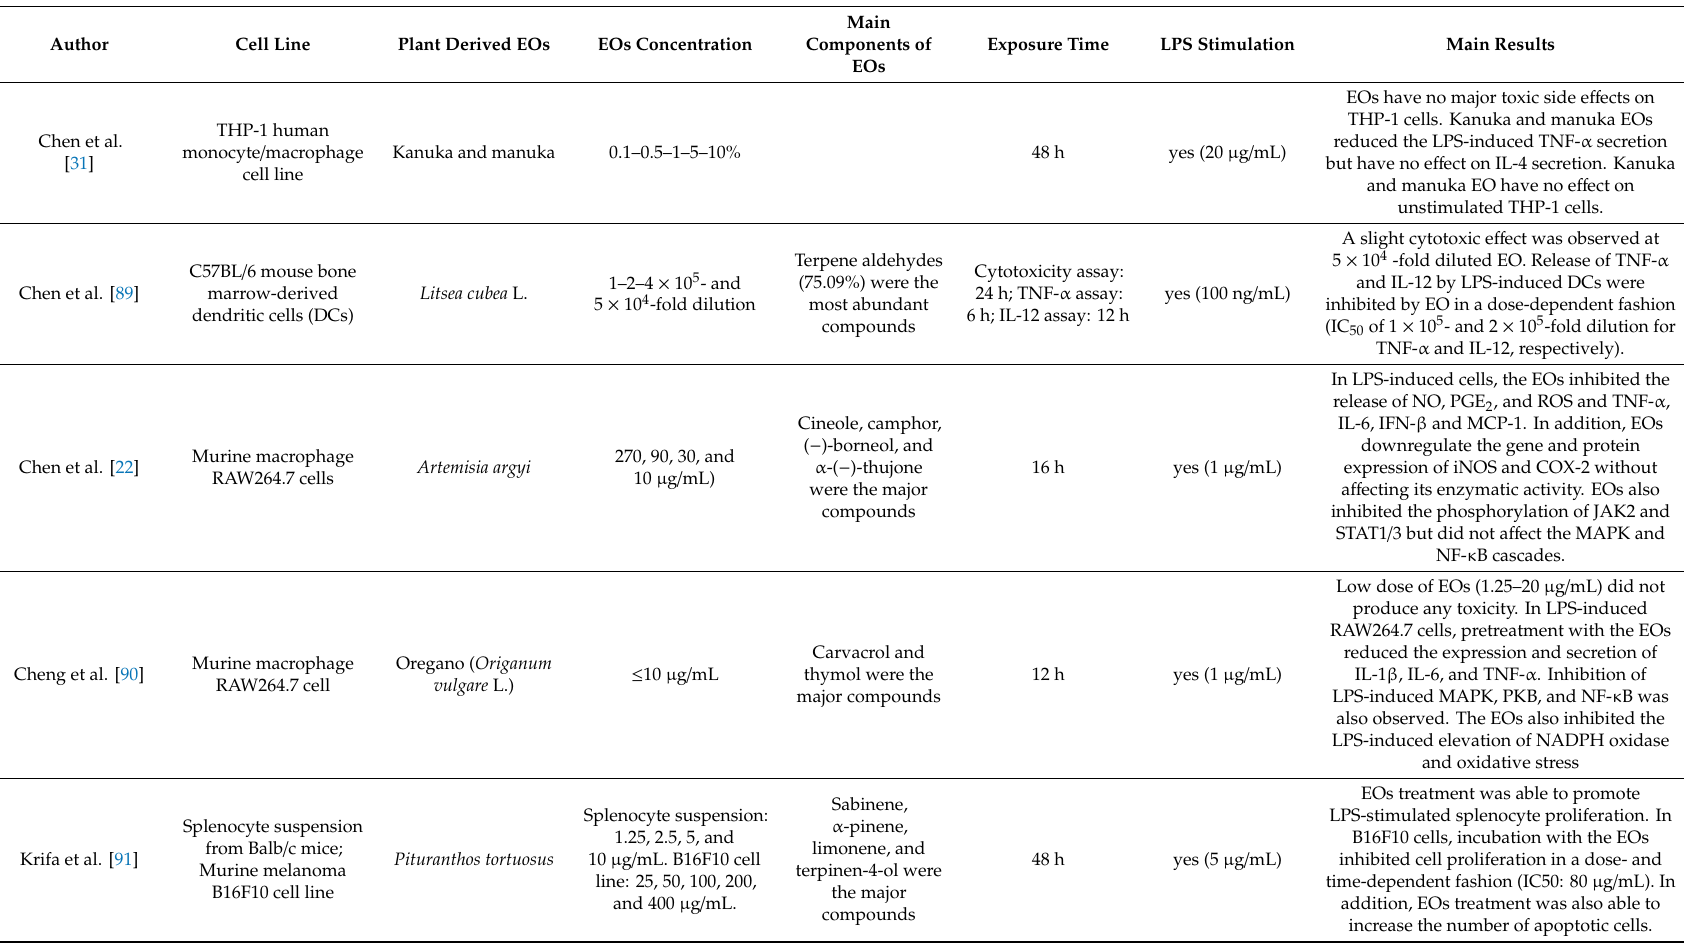
Table 4. Main characteristics of studies related with immunomodulatory properties of essential oils in